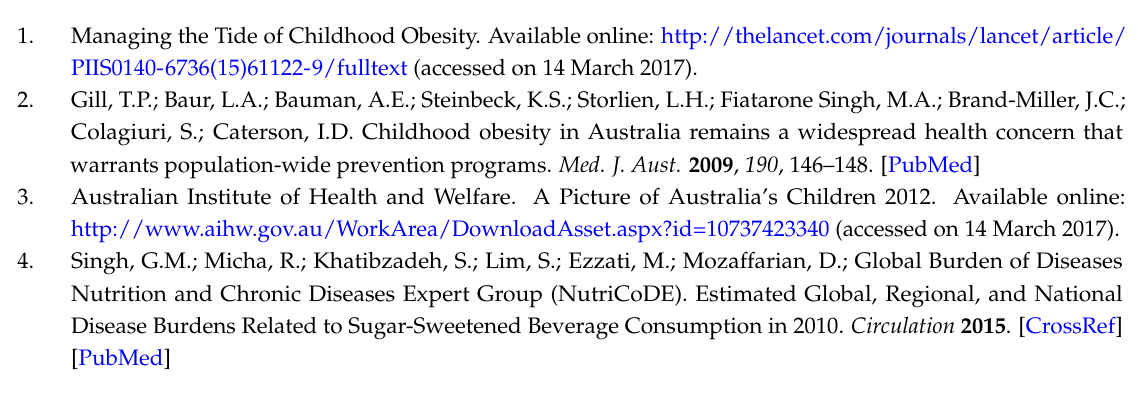
Table S1: Full sample characteristics, Table S2: Full characteristics of the three identified clusters with respect to approval of